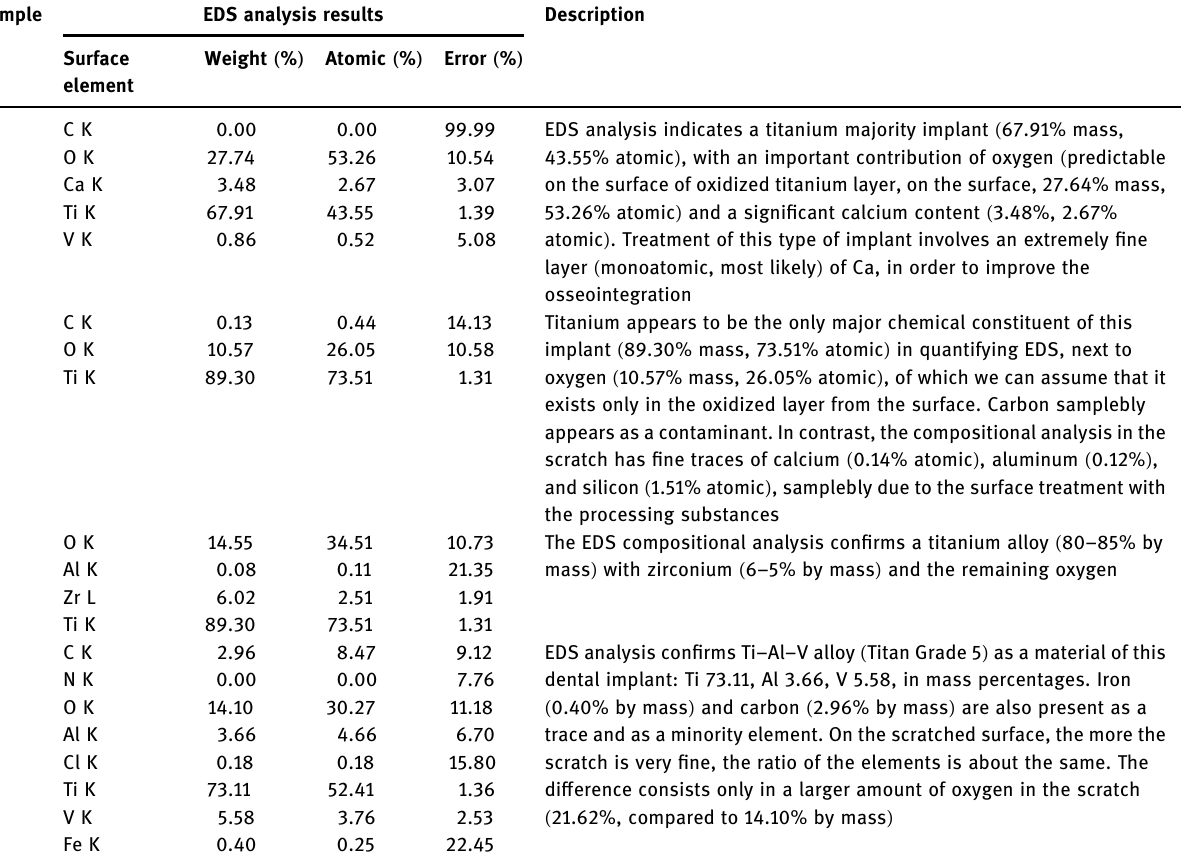
Table 2: EDS compositional analysis of the studied samples Sample EDS analysis